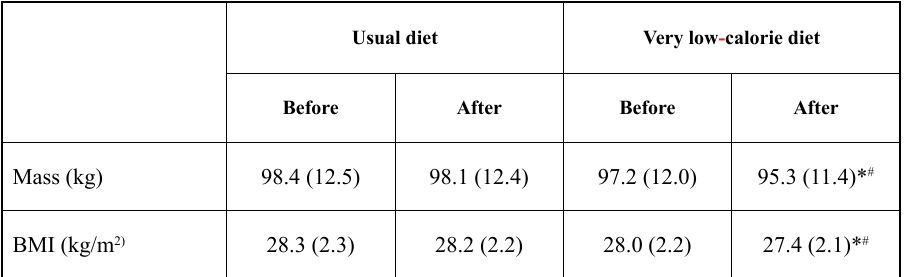
Table 1. Effect of a 2-day very low-calorie diet on anthropometric characte- ristics of the participants Notes. Data are presented as mean (standard deviation). BMI, body mass index; * p < .05, compared